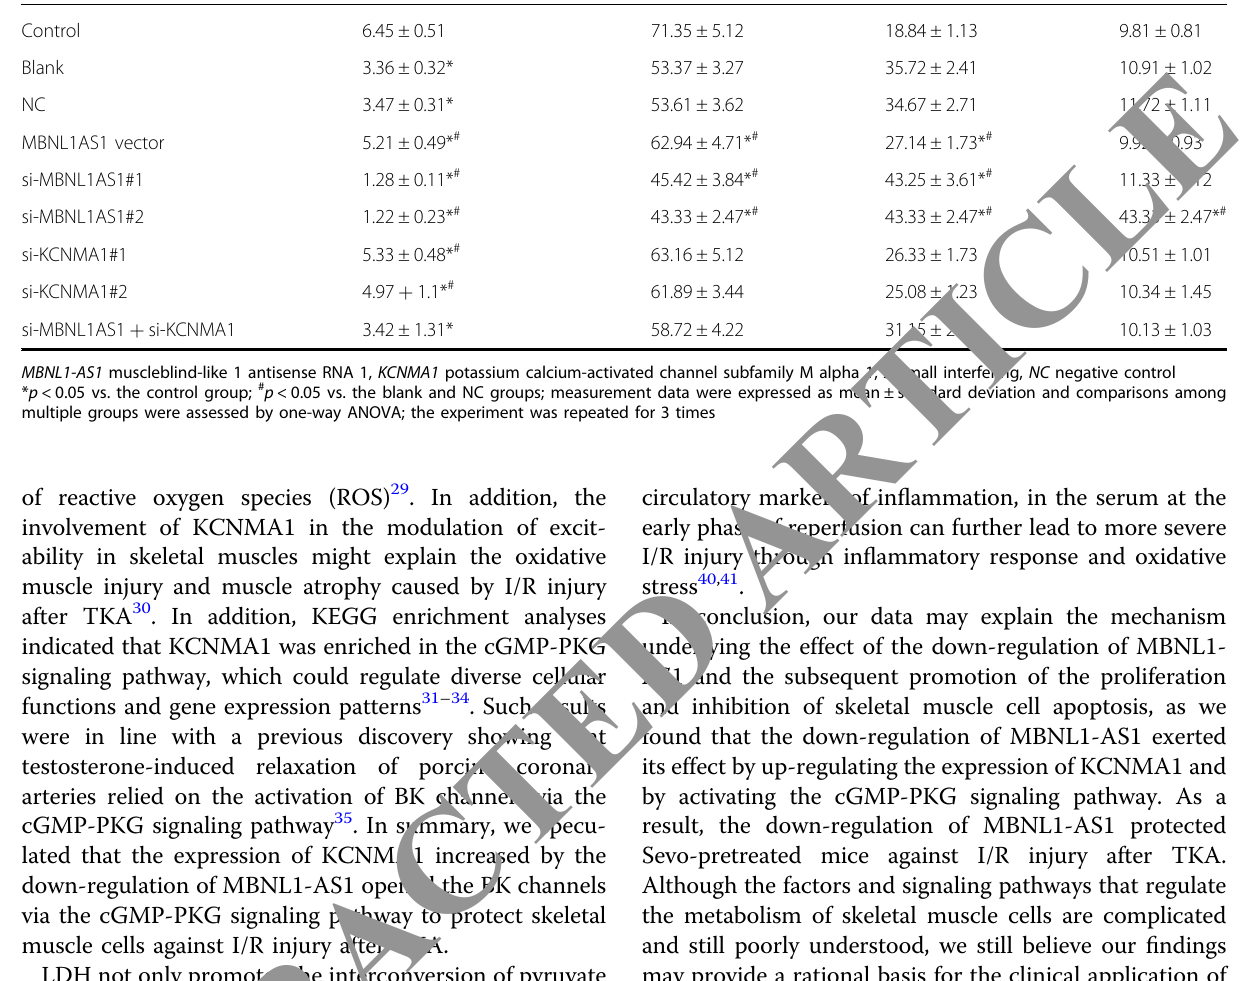
Table 3 Apoptosis rate and cell cycle distribution of skeletal muscle cells among seven groups